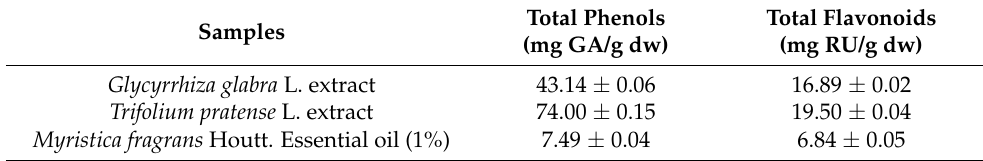
Table 1. The results of samples total phenol and flavonoid